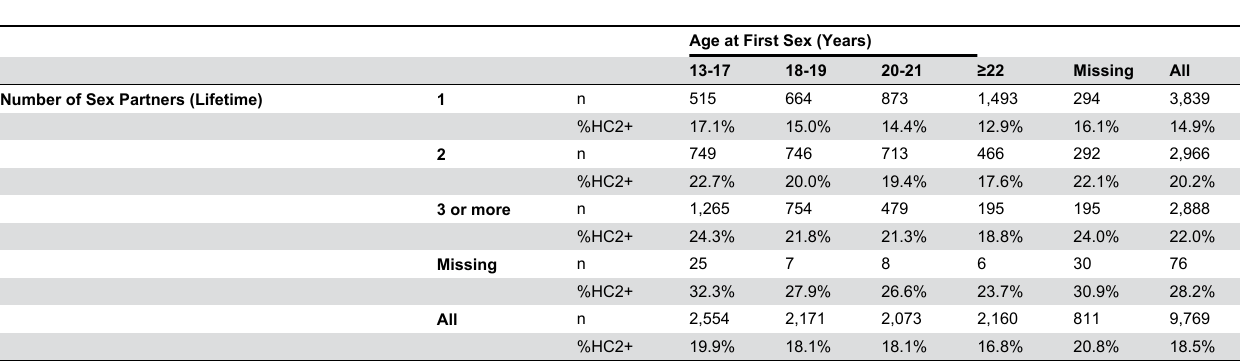
Table 2. HPV prevalence by number of partners and age of first